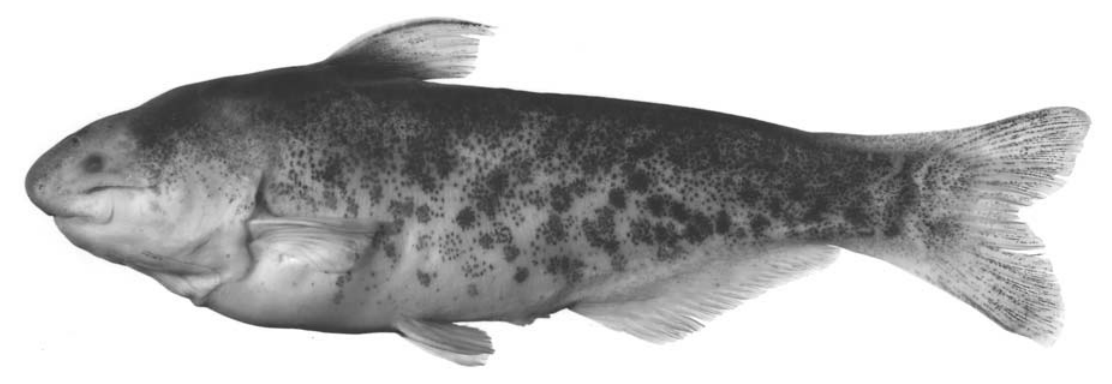
Fig. 40. Cetopsis sandrae , new species, paratype, female, MZUSP 83227, 75 mm SL; Brazil, Mato Grosso, Nova Mutum, unnamed Córrego, Fazenda Buriti (13°51’52"S,